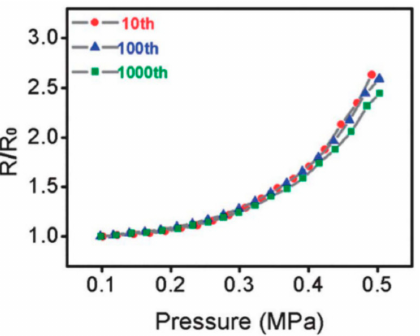
Figure 14. Resistance change versus pressure under cyclic test. Reproduced with permission from [139]. Copyright 2015,